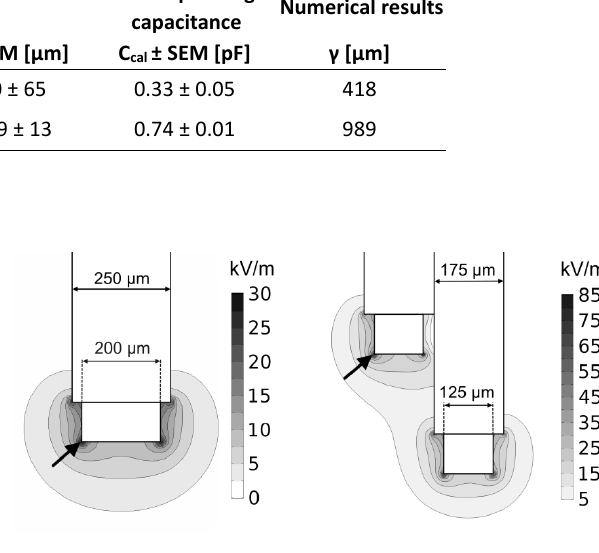
Figure 5: Numerical results of the field strength distributions in the central plane of the unipolar and bipolar electrodes. The 200 µA constant-current setting at medium conductivities of 0.1307 S/m led to potentials of 1.56 V and 3.69 V against the counter electrode at ground potential (0 V) for the unipolar and bipolar electrodes, respectively. Please note that the distributions are not axially symmetric for the bipolar